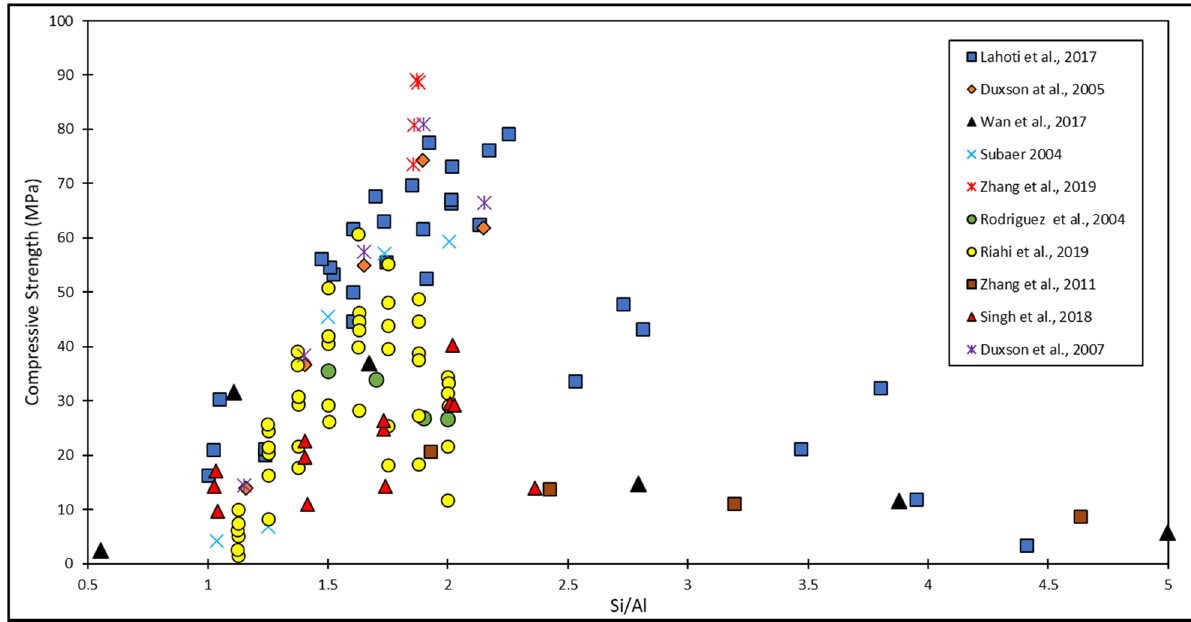
Figure 3: Graph compiling compressive strength vs Si/Al ratio data obtained from previous investigations ( 16,40,71 – 75 )